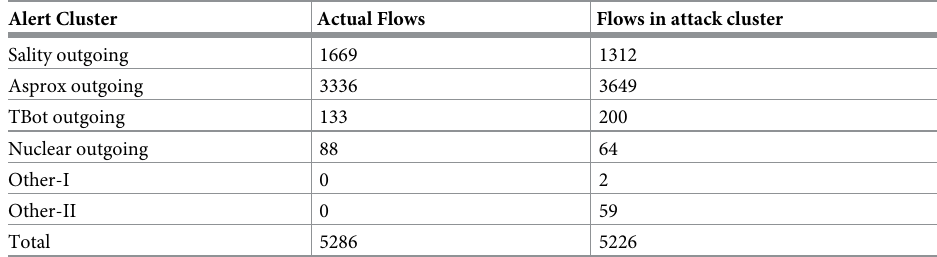
Table 10. SOM clustering results—Malware and APT dataset.